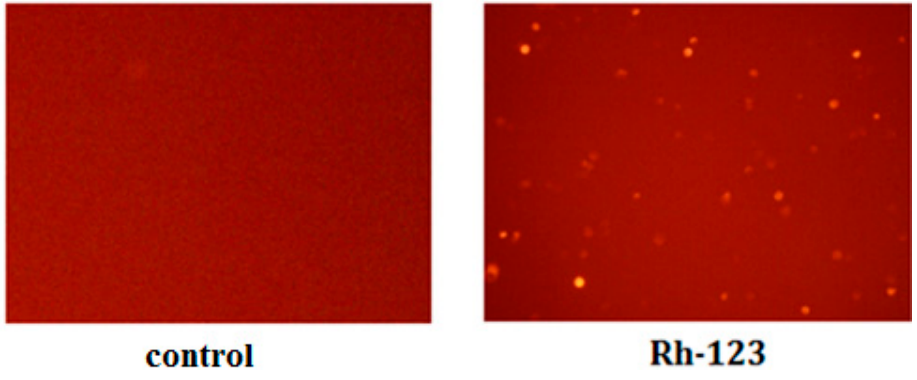
Figure 4. Fluorescent density of cells at the present of Rh-123 or not. Table 3. Effect of imperatorin on the accumulation of Rh-123 (x ± sd, n = 4). Group Dose (µg/mL)